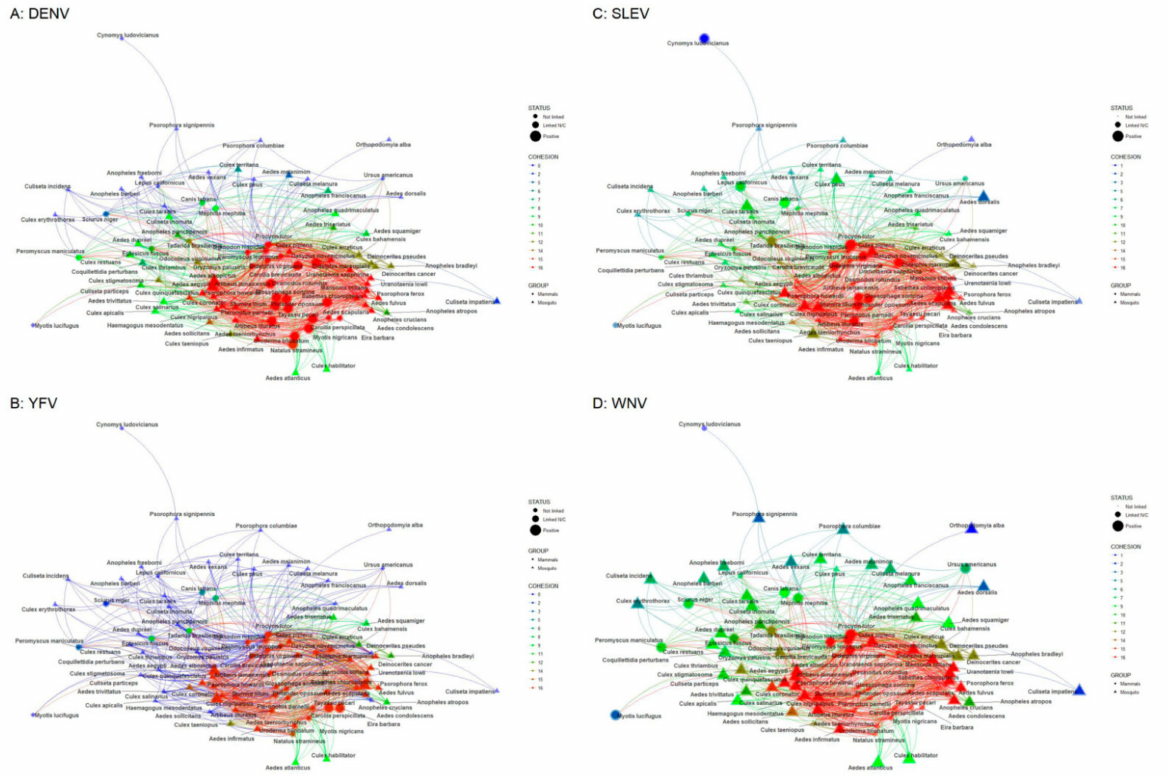
Figure 3. Cohesion analysis by path detection. STATUS: represents the confirmation and path relationship between nodes (Positive: Nodes reported as positive to MBFV, Linked N/C: Nodes linked to a positive node but not confirmed, not linked: Nodes without an Edge to any positive node). COHESION: Cohesion value (greater value implies more cohesion). GROUP: type of node (circle: mammals, triangle: vectors). ( A ): Dengue (DENV), ( B ): Yellow fever virus (YFV), ( C ): St. Louis encephalitis virus (SLEV) and ( D ): West Nile virus